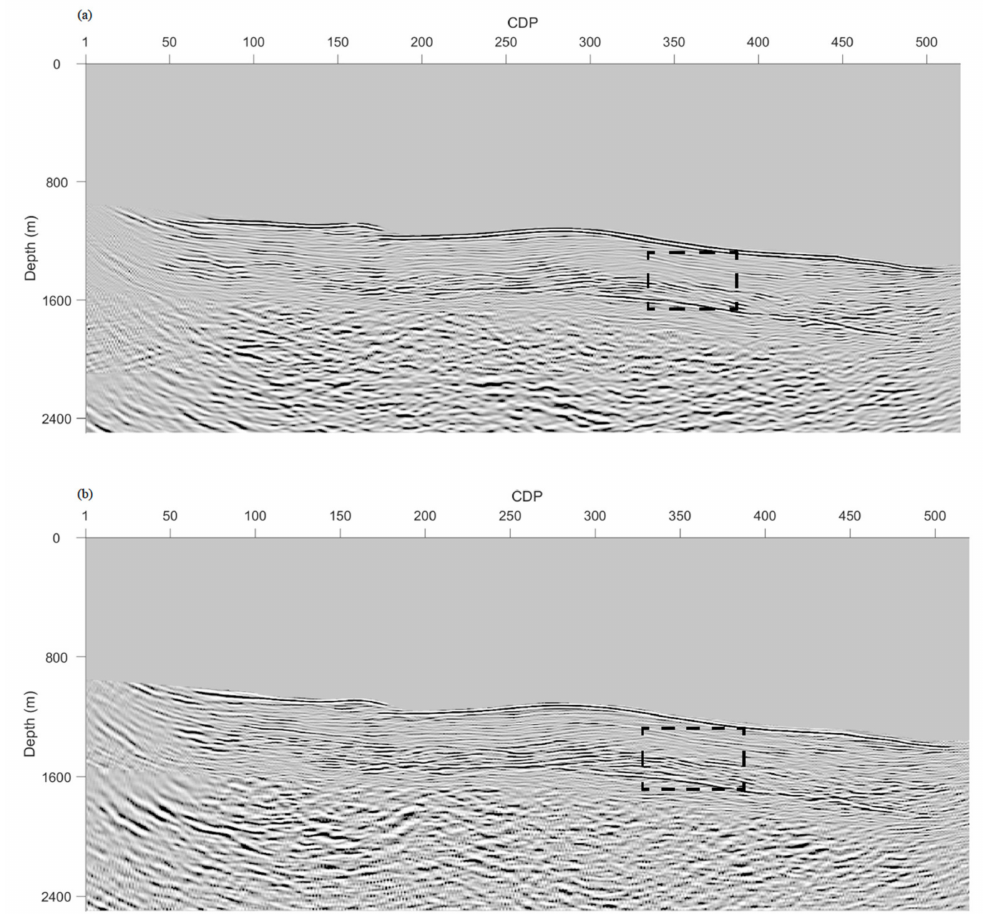
Figure 3. Imaging sections obtained by ( a ) the conventional one-way wave equation migration; and ( b ) amplitude-preserved one-way wave equation migration.